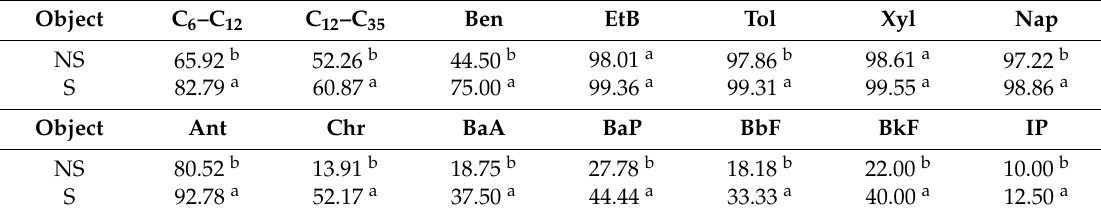
Table 2. Degradation of hydrocarbons in soil, non-sown and sown, contaminated with diesel oil (DO), %.